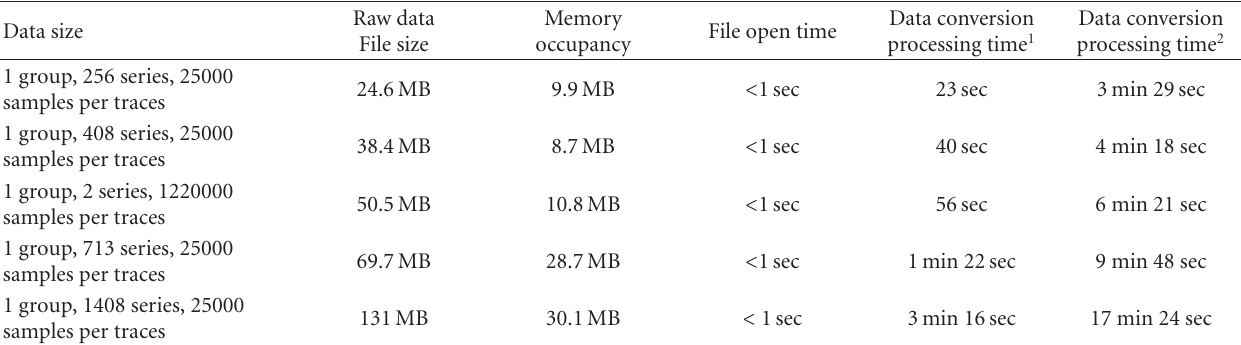
Table 4: Processing benchmarks for PCDReader using a 2.8 GHz Pentium 4